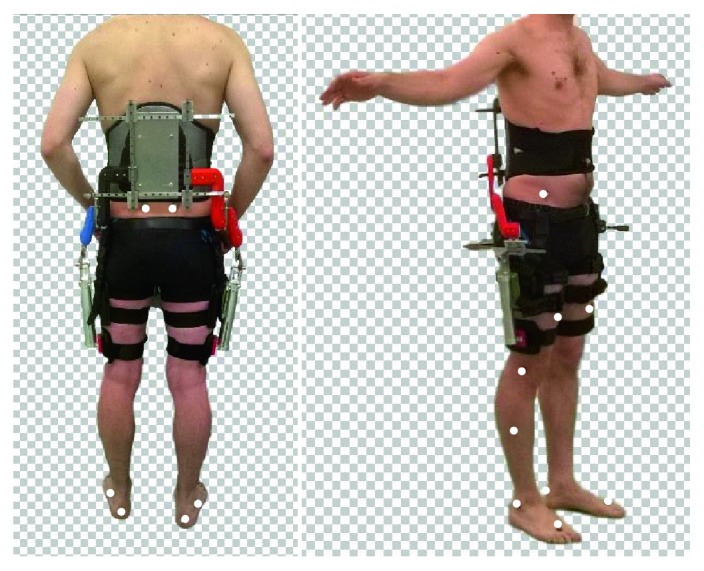
Placement of the markers according to the lower body plug-in-gait marker-set. Markers are placed on the pelvis (ASIS and PSIS), thigh, knee, shank, ankle, heel, and toe.